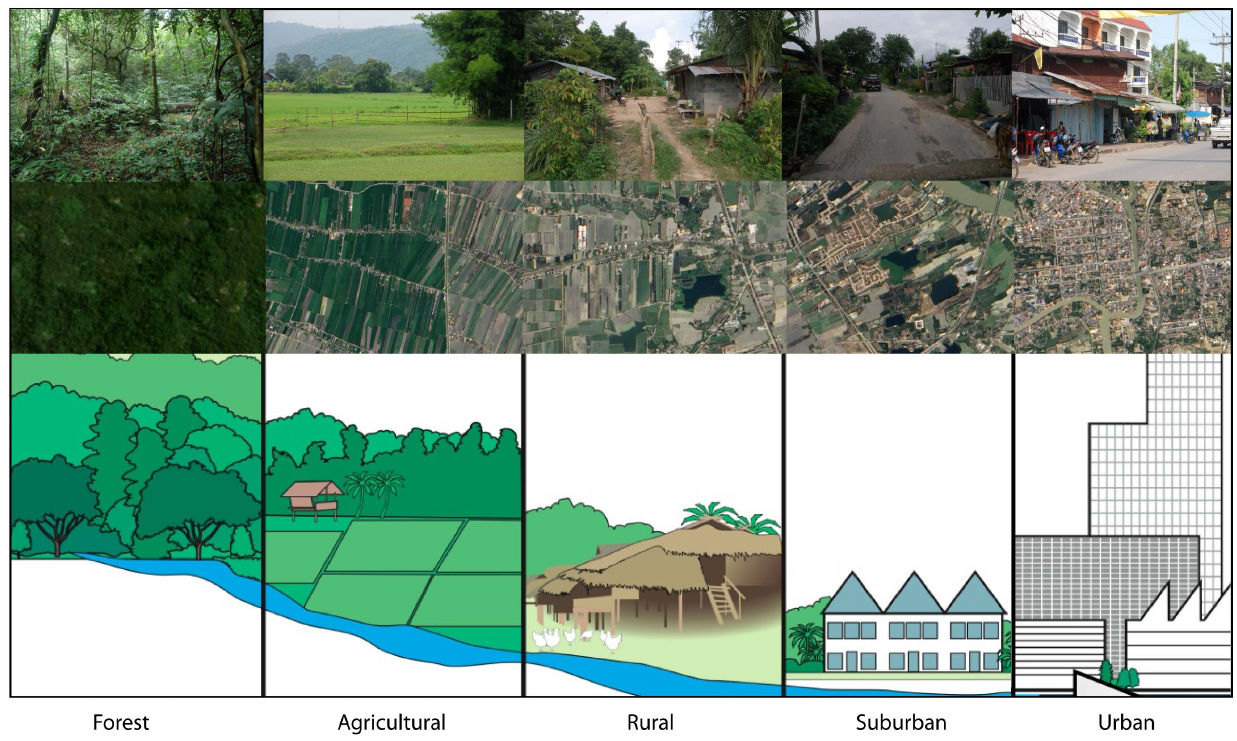
Figure 1. Habitat degradation gradient. Habitats found in central Thailand (top; photos by PT) represent landscape types with increasing degrees of anthropogenic modification (bottom, from left to right; drawings by Nancy Hulbirt, SOEST Illustrations) and biodiversity loss of flora and fauna, as seen by remote imaging (middle; images from NASA’s Earth Observatory). Left to right: forest habitats with high biodiversity; agricultural habitats with mixed farming and forest patches to monocultures; rural habitats with some human dwellings, family farming and forest patches; suburban habitats with more human dwellings, some commercial activity, and fewer forest patches; urban habitats with dense residential and commercial activities and little to no forest